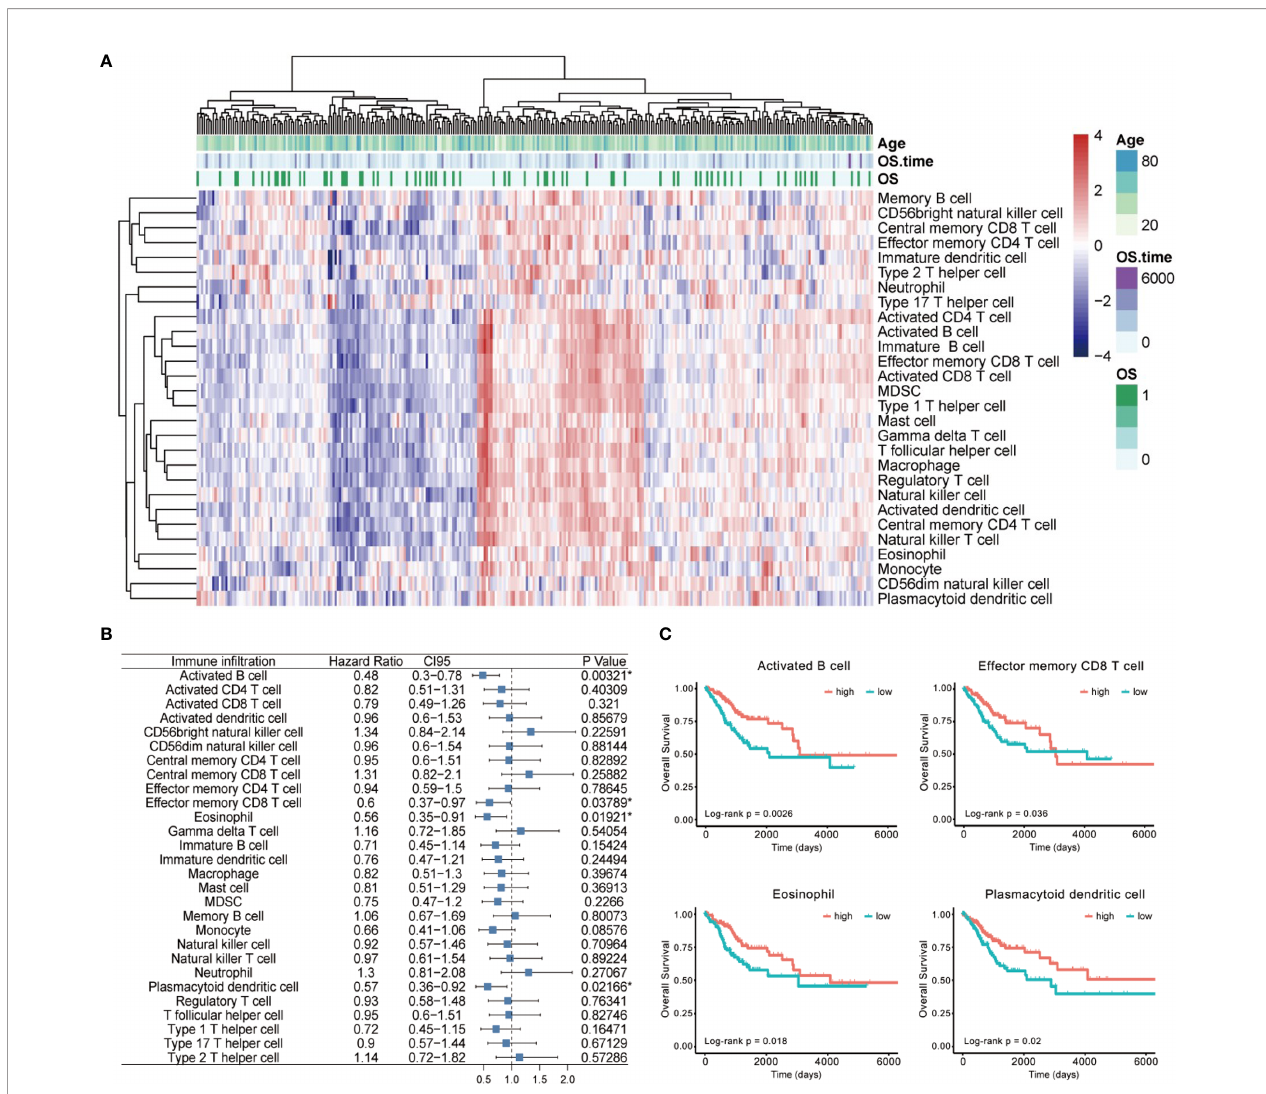
FIGURE 2 | The landscape of immune cell in fi ltration of CESC. (A) The heatmap for normalized enrichment scores of 28 immune cell types in cervical cancer of the TCGA cohort. Rows represent tumor-in fi ltrating cells, and columns represent samples. (B) A forest map showed four immune cells of prognostic value identi fi ed by Cox proportional hazard regression in the stepwise method. (C) Kaplan – Meier curves for overall survival (OS) of all CESC patients with the four identi fi ed immune cell-in fi ltrating classes. Log-rank test showed p < 0.05 respectively. *p <